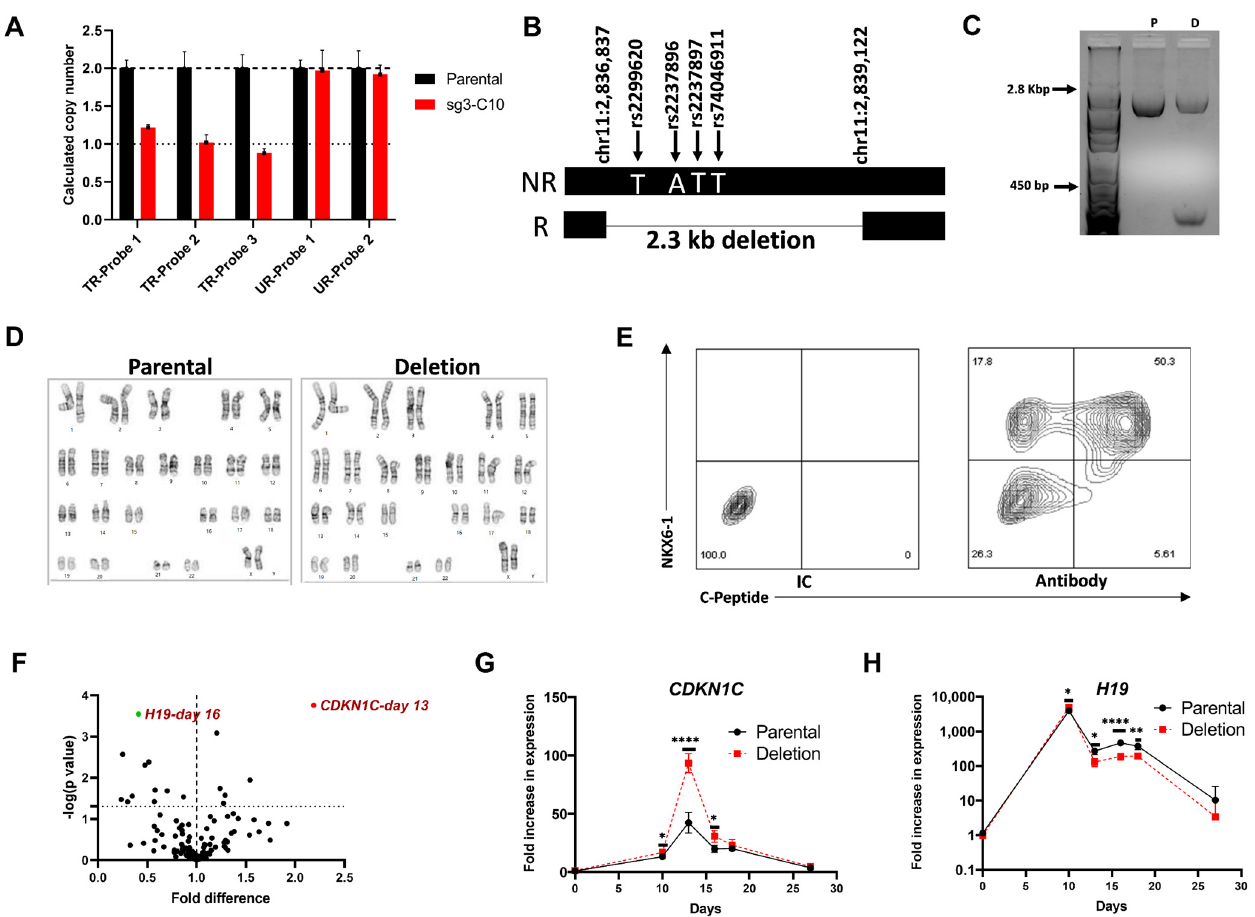
Figure 5. Stage specific differential expression of CDKN1C and H19 in cells with a 2.3 kb hemizygous deletion in KCNQ1 intron 15 that spans the four putative functional SNPs. ( A – D ). Characterization of a clonal cell line with a 2.3 kb hemizygous deletion at the KCNQ1 locus. ( A ). Copy number assay (CNV) showing hemizygous deletion in sg3-C10 (deletion cell line). TR probes—CNV probes mapping to the CRISPR targeted region. UR probes—CNV probes mapping to the upstream region. Data shown is part of Figure 3B. ( B ). Figure showing the 2.3 kb deletion in the allele with the risk haplotype for the four putative functional SNPs at the KCNQ1 locus. ( C ). Confirmation of the hemizygous deletion by agarose gel electrophoresis of the PCR amplicon generated by long PCR using primers spanning the deletion. P = parental cell line, D = deletion cell line (sg3-C10). ( D ). Karyotyping by G-banding of the parental and deletion cell line. ( E ). Representative flow cytometry data of islet-like cells generated by differentiating the deletion cell line using differentiation protocol 2 showing staining for INS (C-peptide) and the beta cell transcription factor NKX6-1. IC— isotype control. Data also shown in Figure S4. ( F – H ). Stage specific differential expression of CDKN1C and H19 during islet-like cell differentiation from hiPSCs. ( F ). Statistical significance and fold difference in the expression of 20 genes at the KCNQ1 locus in the cells with the deletion relative to the parental cells during days 0, 10, 13, 16, 18 and 27 of differentiation. The x -axis shows the fold difference in expression and the y -axis show the -log( p -value). The dashed horizontal line indicates a p = 0.05. Results are from four independent differentiations and expression was calculated relative to expression in the parental cells from experiment 1 from the respective days. Results were compared using t -test. ( G , H ). Fold change in the expression of CDKN1C and H19 during differentiation of the deletion cell line and the parental cell line to pancreatic islet-like cells relative to the expression in hiPSCs. Results are from four independent differentiations; the error bars show SD and results were compared using t -test. Expression was calculated relative to expression in parental hiPSC from experiment 1. * p < 0.05, ** p < 0.01, **** p <